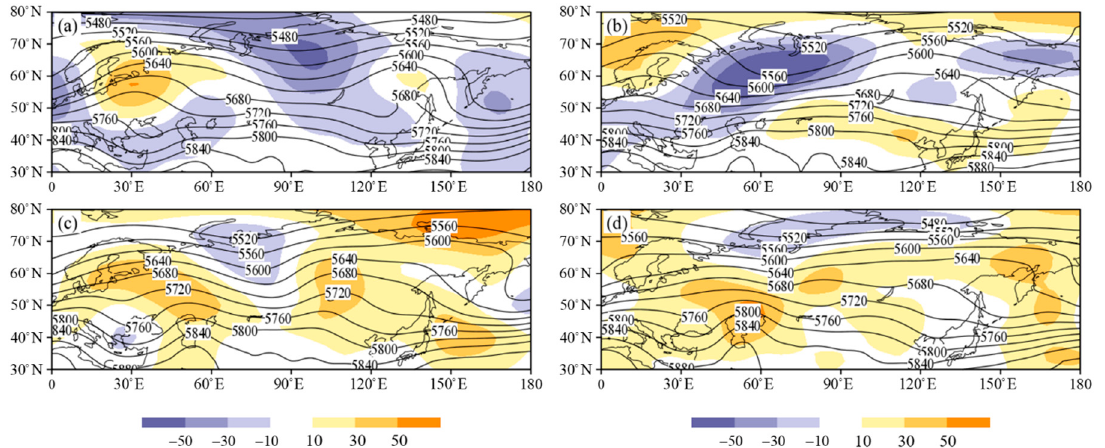
Figure 6. The geopotential height fields at 500 hPa (solid line, units: gpm) and anomaly field compared with climatological state (shaded, units: gpm) of early-arriving Meiyu in the 1990s ( a ), late-arriving Meiyu in the 1990s ( b ), early-arriving Meiyu in the 2010s ( c ), and late-arriving Meiyu in the 2010s ( d ).